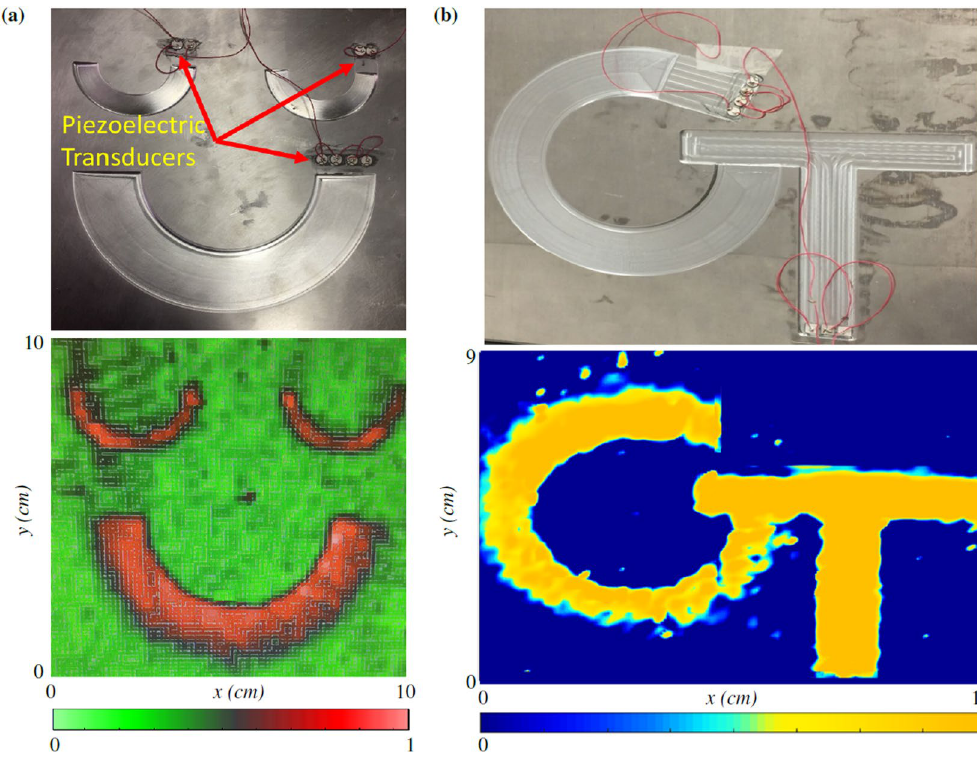
Figure 5. Experimentally measured patterns and shapes. Experimentally-measured normalized RMS wave response generated by piezoelectric transducers at f = 50 kHz for (a) a smiley face, (b) GT logo.